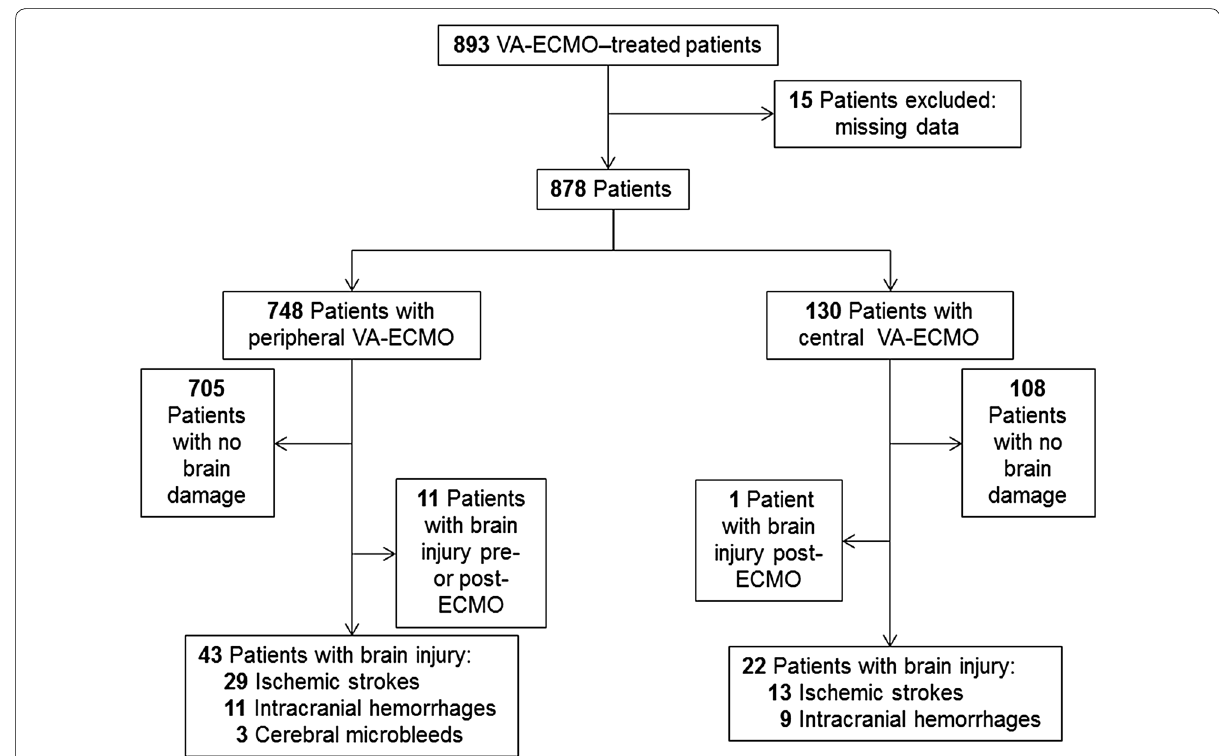
Fig. 1 Flowchart of the study. VA‑ECMO, venoarterial‑extracorporeal membrane